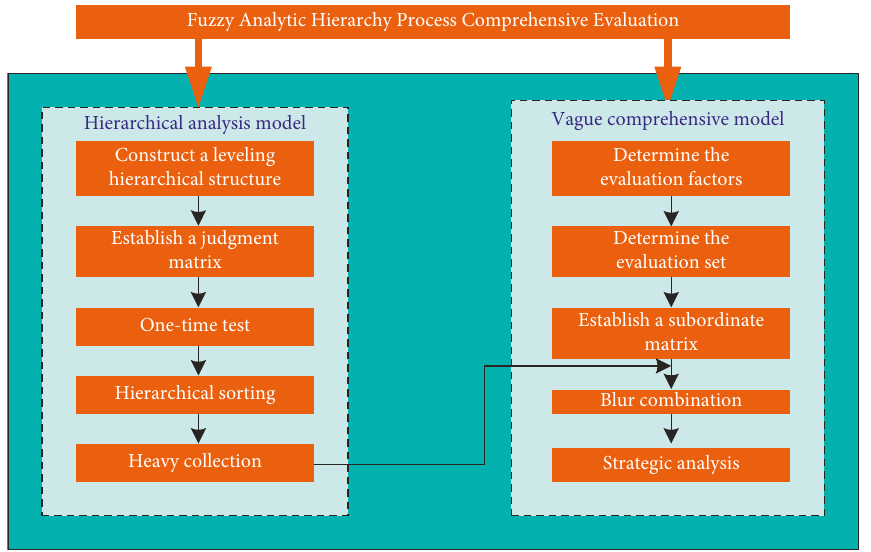
Figure 4: Structural model diagram of the fuzzy